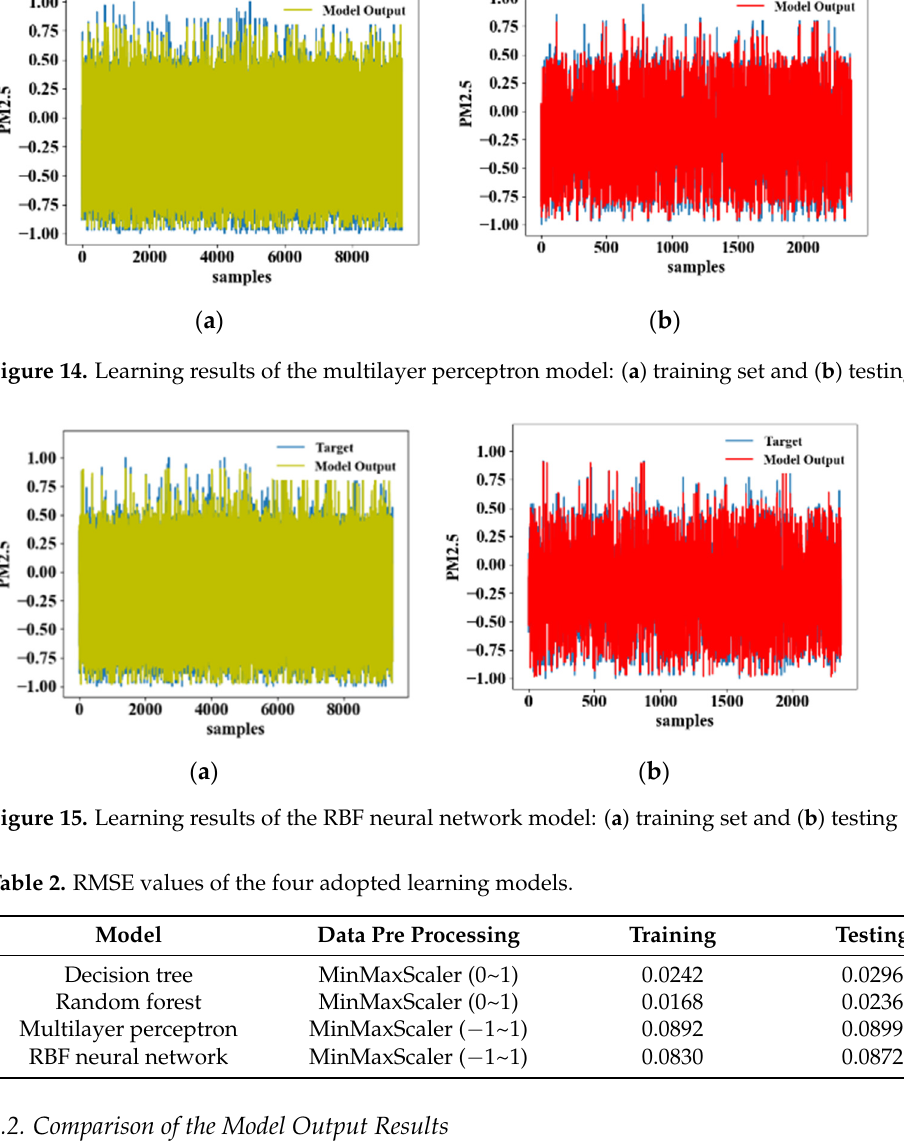
Figure 13. Learning results of the random forest model: ( a ) training set and ( b ) testing set.